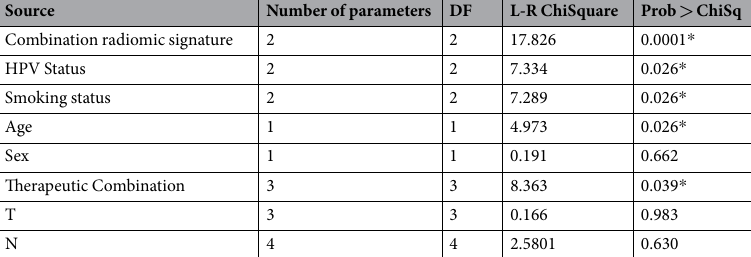
Table 3. Effect Likelihood Ratio Tests (L-R = Likelihood ratio).